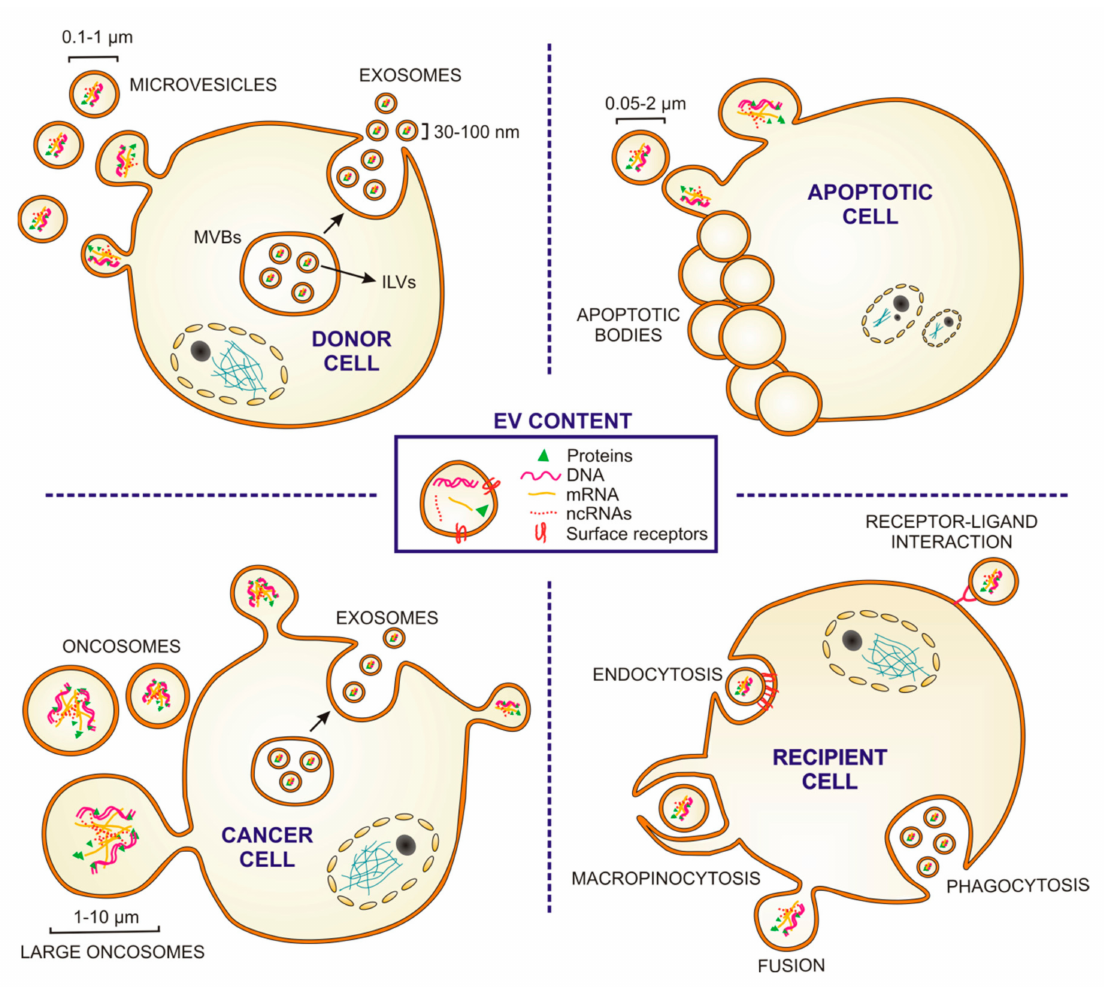
Figure 1. Extracellular vesicles: types, sizes, content, biogenesis and uptake. Cartoon depicting the origin and sizes of di ff erent types of extracellular vesicles (EVs). Microvesicles are released by outward budding of the plasma membrane, and exosomes from the endosomal system via fusion of multivesicular bodies (MVBs) with the cytoplasmic membrane which releases the intraluminal vesicles (ILVs) (see “DONOR CELL”). Apoptotic bodies are EVs released by membrane budding of cells dying by apoptosis (see “APOPTOTIC CELL”). Some tumor cells release oncosomes and / or large oncosomes (see “CANCER CELL”). EVs can be taken up through di ff erent mechanisms: macropinocytosis, phagocytosis, endocytosis or fusion. They can also interact with receptors in the recipient cell membrane (see RECIPIENT CELL). EVs contain cytosolic components (soluble proteins, DNA, mRNA and non-coding RNAs (ncRNAs)) and express surface molecules of their cell of